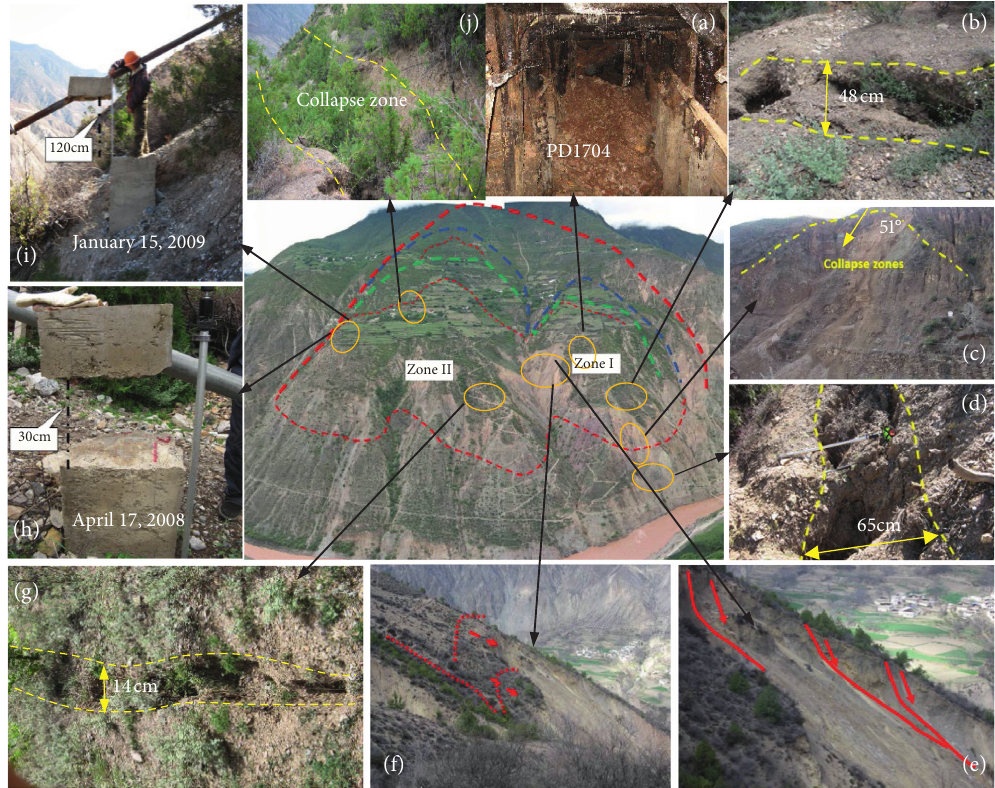
Figure 8: Crack propagation and collapse characteristics of subslide zones I and II. (a) Soil collapse and wood forepoling damage in PD1704. (b) A tensional crack (Apr. 2009). (c) Shear sliding outlet with a local collapse failure in the front part of the landslide mass (Apr. 2009). (d) A tension-collapse belt at the rear edges of EL 2130–2150m (Jan. 2009). (e) Instability model of gradual disintegration on the left side of the Zhenggang gully. (f) Instability zone of gradual disintegration on the left side of the Zhenggang gully. (g) Several groups of medium fractures in the front of zone II, with elevations of 2250–2400m. ((h) and (i)) Failure of a concrete pier photographed on April 17, 2008, and January 15, 2009, respectively. (j) Tension-collapse belt at the rear part of EL 2650m (Jan.